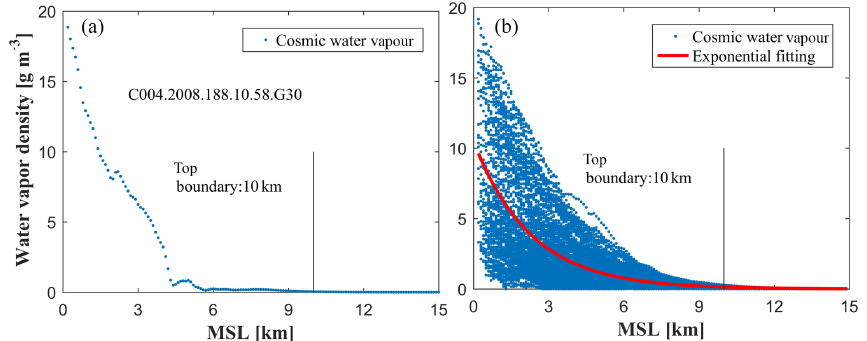
Figure 4. The vertical distribution of water vapour density in a single COSMIC RO event (a) and the 3-D water vapour distribution of tomography area and exponential fitting curve from 2006 to 2016 (b) ; the x axis shows the mean sea level (MSL) altitude.